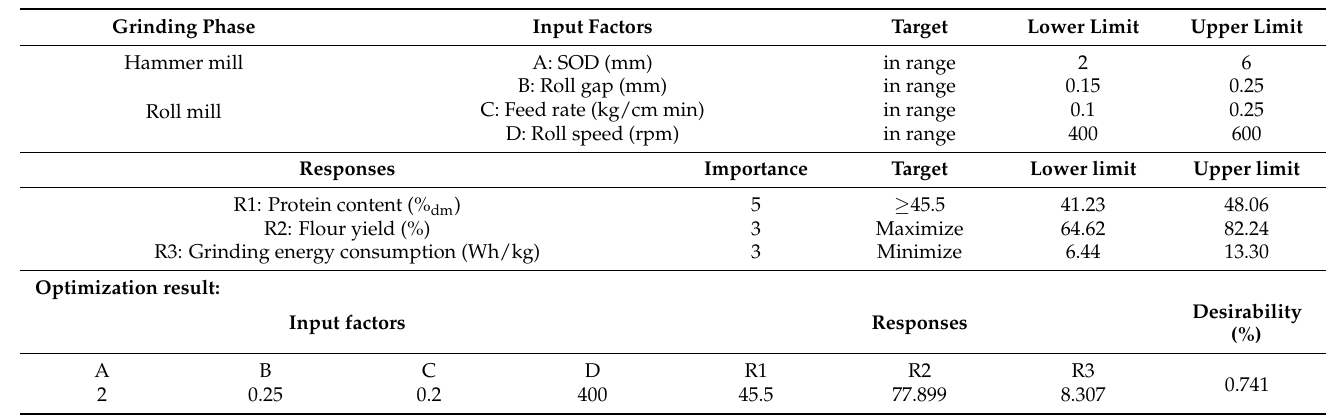
Table 6. Optimization of the fractionation process: targets and limits for input factor and responses and